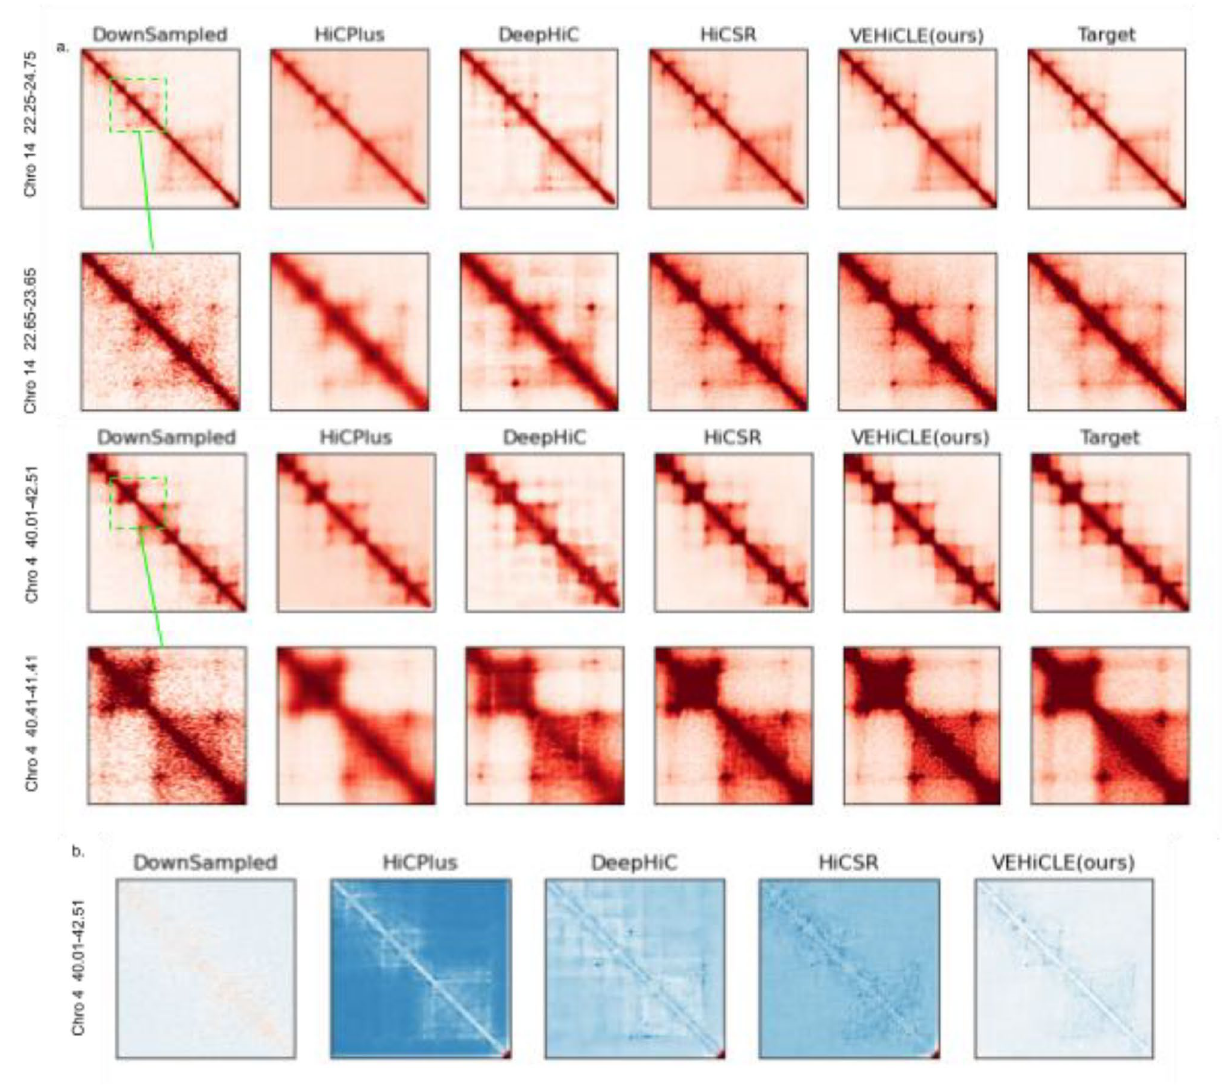
Figure 4. Visual Comparison of deep learning based methods for contact matrix enhancement. ( a ) Visual comparison of enhancement matrices. ( b ) Absolute difference matrices between target high resolution data and enhancement. All displayed matrices are derived from the GM12878 cell line. Architectures of previous models utilize original window